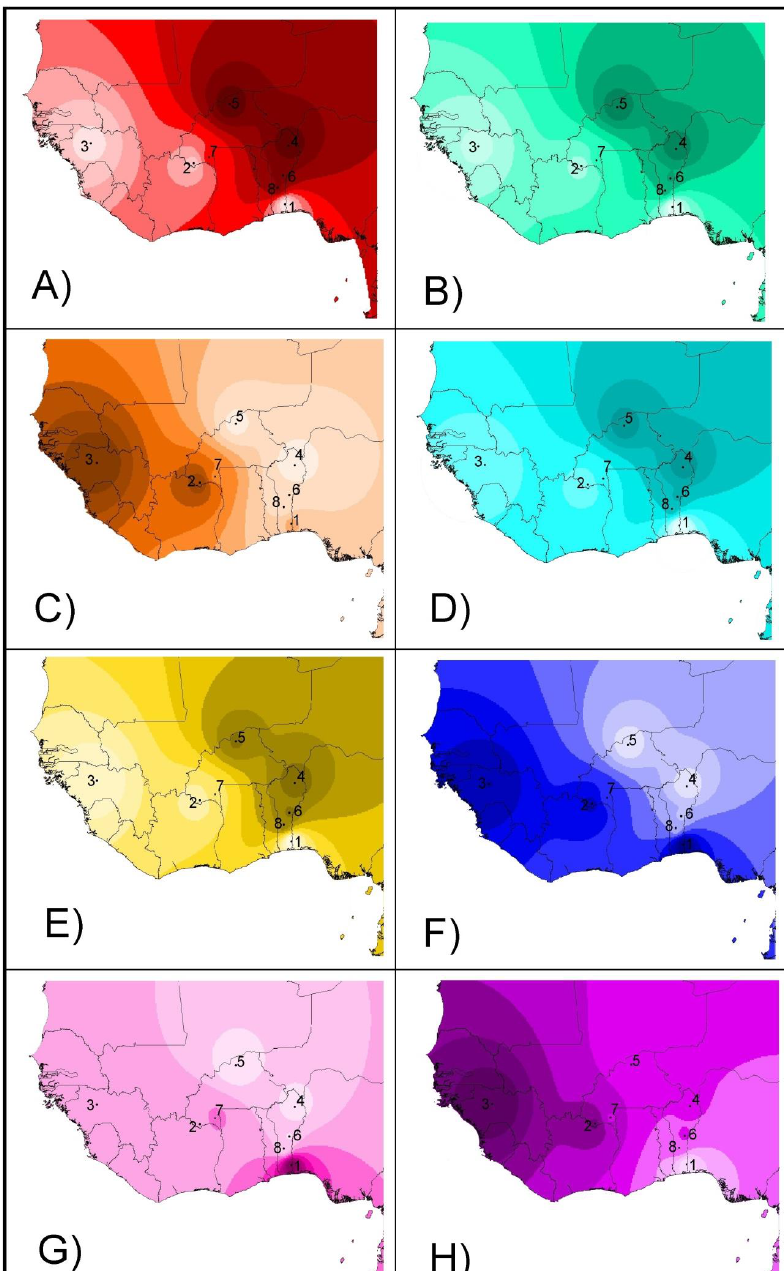
Figure 4. Synthetic maps illustrating the geographical variation of the individual admixture ( 𝑞̂ ) estimated on microsatellite (Plot A ) and SNP (Plot B ) variation assuming K = 2. The same maps were constructed using the first (Plots C and D ), second (Plots E and F ), and third (Plots G and H ) factors identified on the microsatellite (left column) and SNP (right column) variation. Colors should be interpreted as differences between mean 𝑞̂ coefficients or eigenvalues: higher val- uesare darker. Points illustrate the geographical coordinates in which the breeds were considered to be sampled. The IDW option of the Spatial Analyst Extension of the program ArcView was fitted to a power of two assuming that each input point has a local influence that diminishes with distance. Numbers mean the following: (1) Lagunaire; (2) N’Dama (Burkina Faso); (3) N’Dama (Congo); (4) Zebu Peul (Benin); (5) Zebu Peul (Burkina Faso); (6) Borgou; (7) Lobi; and (8) Zou. Populations from 1 to 3 belong to West African taurine cattle, populations 4 and 6 belong to West African zebu cattle, and populations from 6 to 8 belong to sanga cattle.